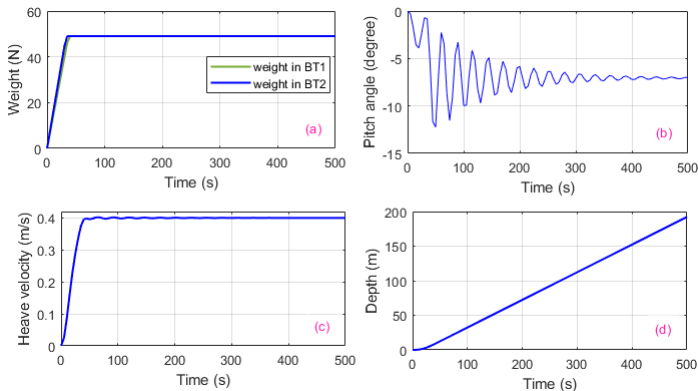
Figure 12. ( a ) Variation of the weight vs. time in both ballast tanks, ( b ) Variation of pitch angle with time, ( c ) Variation of sinking (heave) velocity with time and ( d ) Variation of depth with time in open